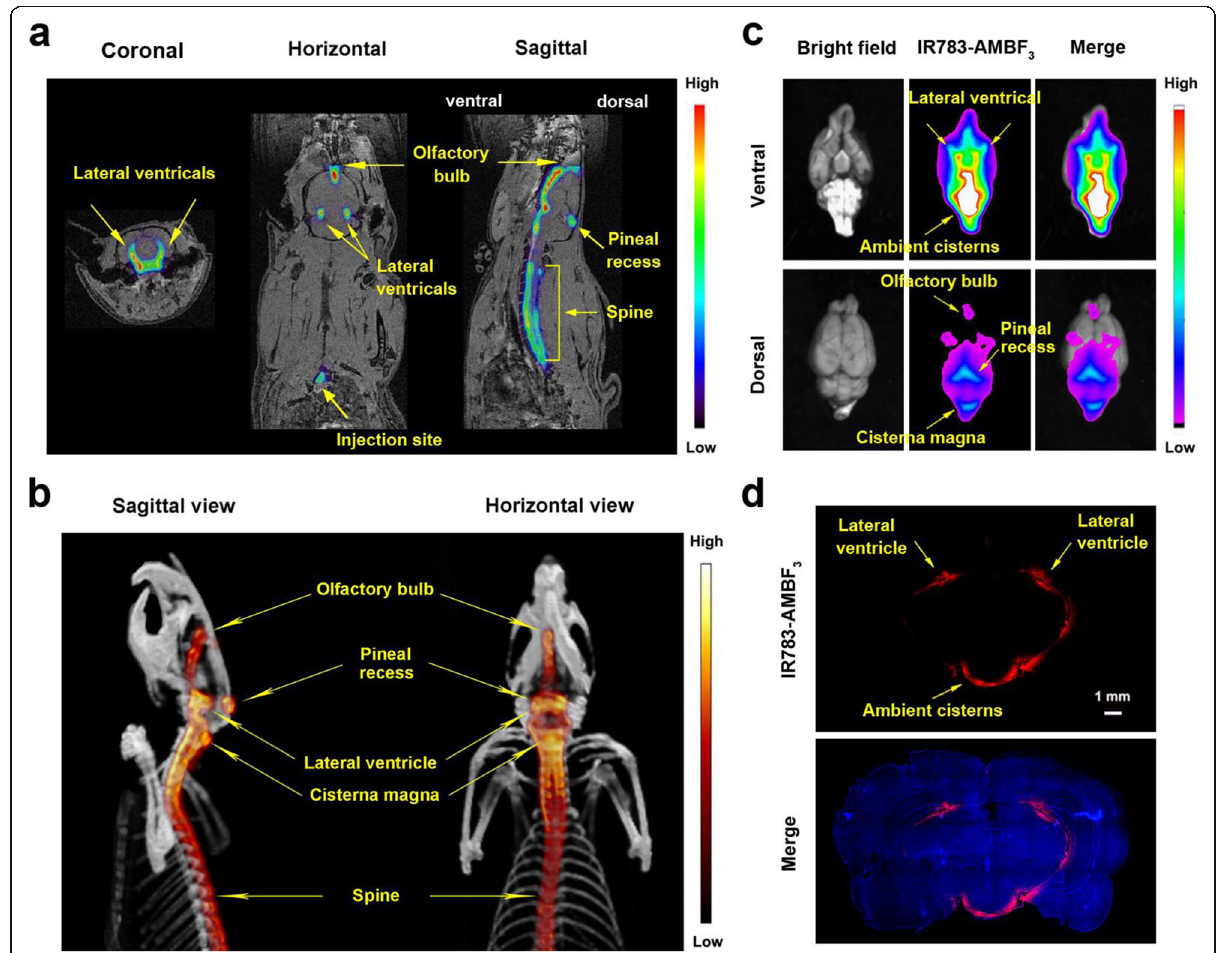
Fig. 1 PET/MRI, PET/CT, and fluorescent visualization of IR783-AMBF 3 distribution in the CNS after intrathecal injection. a A PET/MR scan of a rat following intrathecal introduction of [ 18 F]-IR783-AMBF 3 shows contrast that is clearly visible in the spine, pineal recess, pituitary recess, and olfactory bulb. b Maximum intensity projection PET/CT image of intrathecally injected [ 18 F]-IR783-AMBF 3 at 5 min post injection. IR783-AMBF 3 distributes to the CSF-containing space similarly in a PET/MRI and b PET/CT. c After PET/CT imaging, the rat brain was collected for fluorescent imaging. d Ex vivo fluorescent histology of a coronal section of the brain in a healthy rat that has been injected with IR783-AMBF 3 (10 μ M) after 20 min. DAPI (blue) and IR783-AMBF 3 fluorescent signal (red) show IR783-AMBF 3 in the ventricles where CSF is normally present at